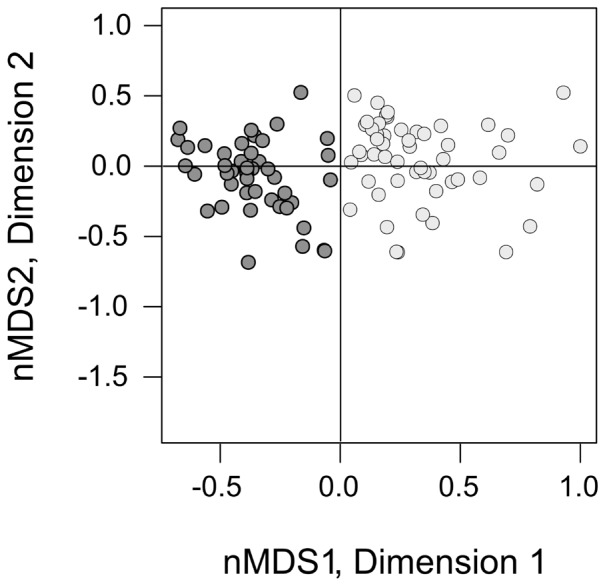
Nonmetric multidimensional scaling (nMDS) ordination plots of parasitic burden by helminths in Chionodraco hamatus.Dark gray circles are for male and light gray for female individual fish. Distances between points represent the difference according to the Bray-Curtis dissimilarity.